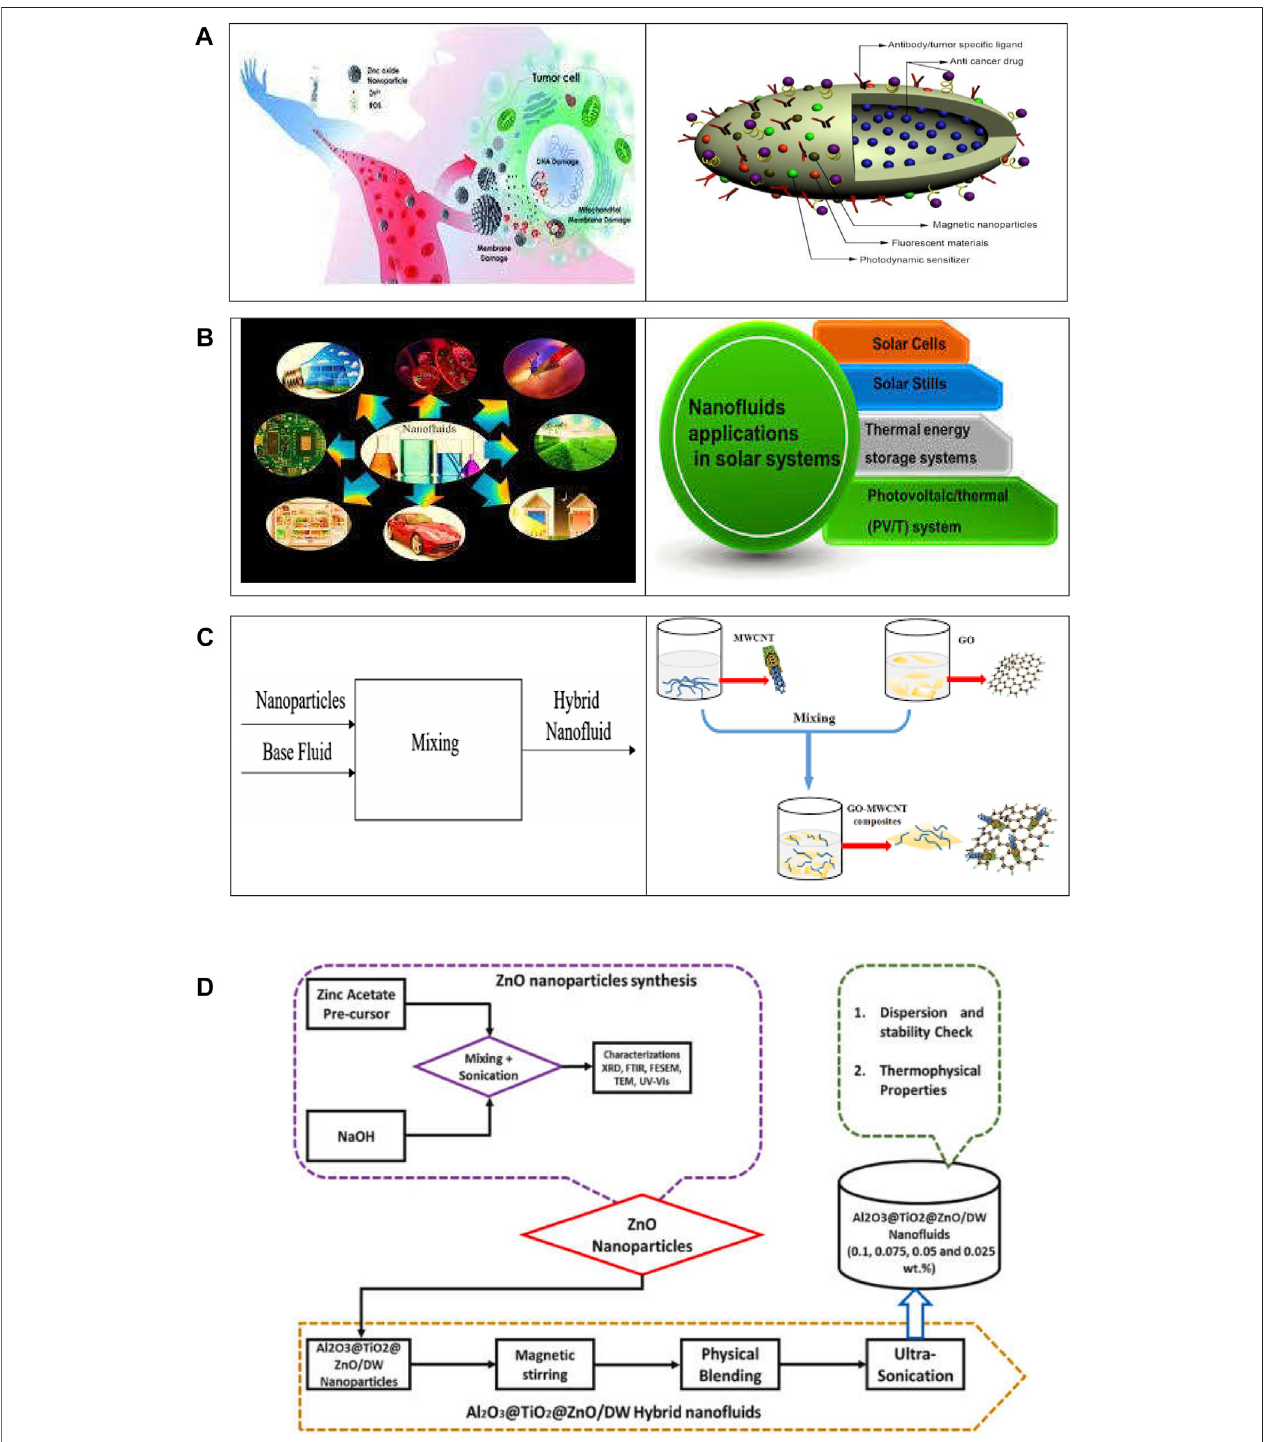
FIGURE 1 | (A) Nanotechnology and the fi eld of biomedical engineering. (B) : Applications of nano fl uids in different zones. (C) : Hybrid nano fl uids ’ synthetization process. (D) : Schematic representation of the synthetization process of ternary hybrid nano fl uids.